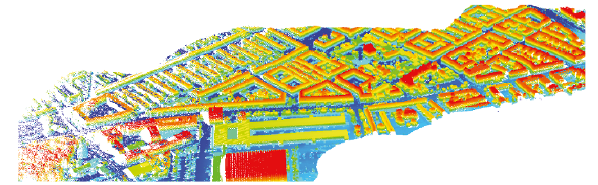
Figure 5: Oblique view of the considered LiDAR area.